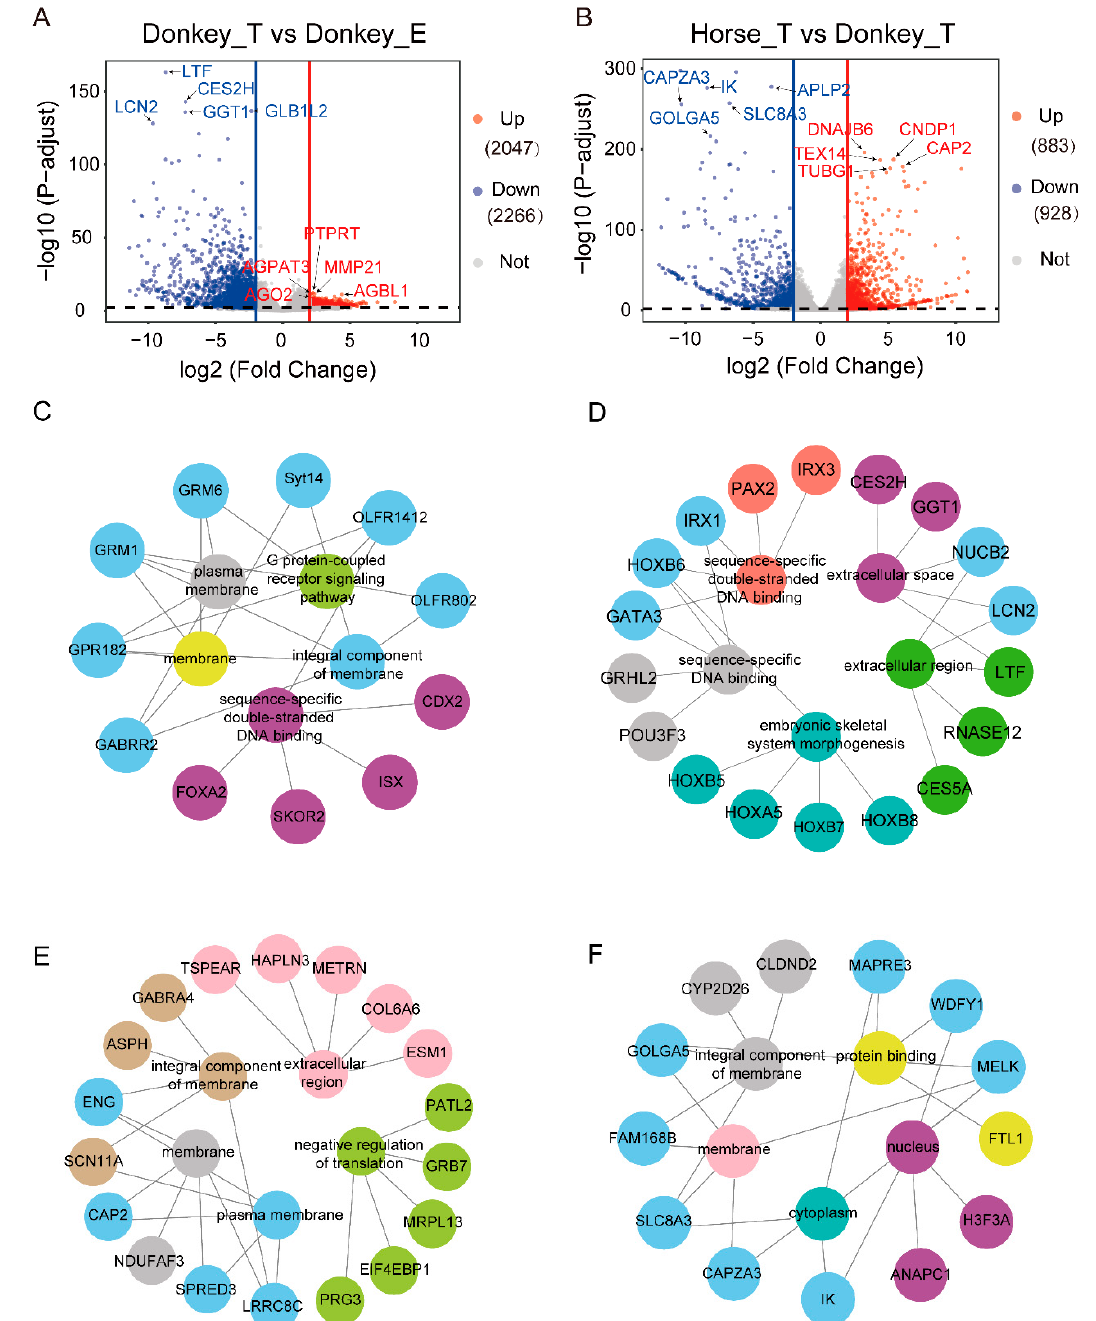
Figure 2. Identification of the tissue–enriched genes in donkeys and horses. ( A ) Volcano plot of DEGs between testis and epididymis tissues in the donkey. Red indicates up–regulated DEGs (up–DEGs); blue indicates down–regulated (down–DEGs). The marked genes are the top five selected by p -adjusted value. ( B ) Volcano plot of the differentially expressed genes in testis tissue between donkey and horse. Red indicates up–regulated DEGs (up–DEGs); blue indicates down–regulated DEGs (down–DEGs). The marked genes are the top five selected by p -adjusted value. ( C ) The inner circle shows the top five GO (biological process) terms for testis tissue–enriched genes in donkeys, and the outer circle shows the genes enriched in the terms. ( D ) The top five GO terms of tissue–enriched genes in donkey epididymis. ( E ) The top five GO terms of tissue–enriched genes in horse testis ( F ) The top five GO terms of tissue–enriched genes in donkey testis. The GO terms refer to the biological processes.